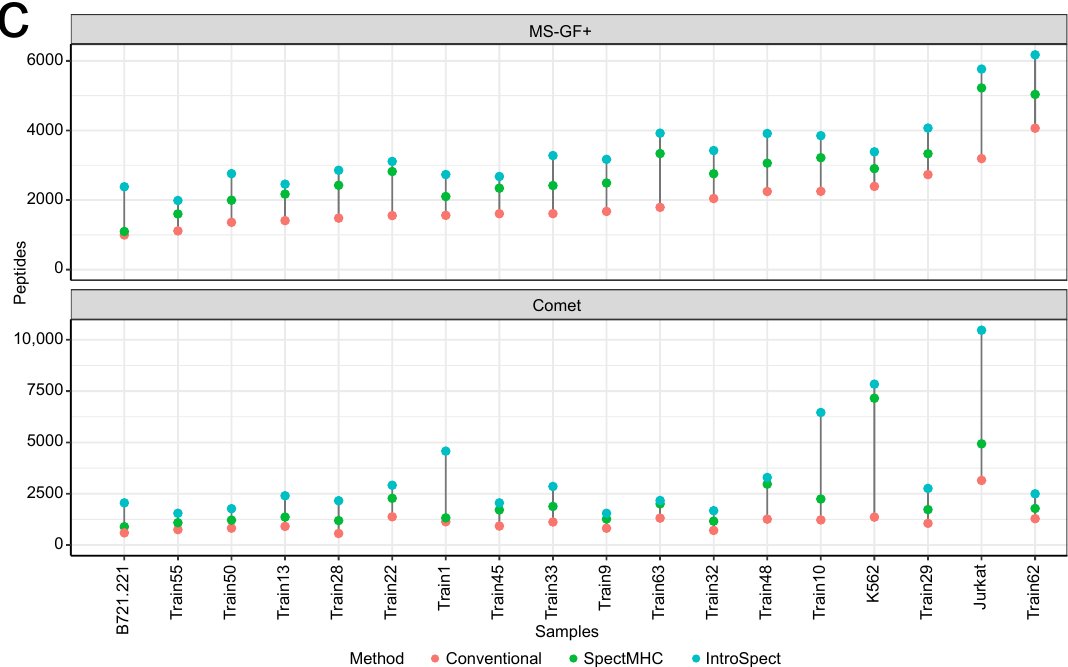
Figure 1. IntroSpect improves peptide identification sensitivity by reducing the search space. ( a ) The flowchart of the conventional database search and IntroSpect database search. ( b ) IntroSpect and SpectMHC decreased the database size and increased the proportion of identified MS/MS spectra with MS-GF+. The database size is calculated as the number of 9–11 mer peptides in the database. ( c ) IntroSpect and SpectMHC significantly increased the identified peptides with MS-GF+ and Comet search engines, while IntroSpect consistently outperformed SpectMHC in terms of